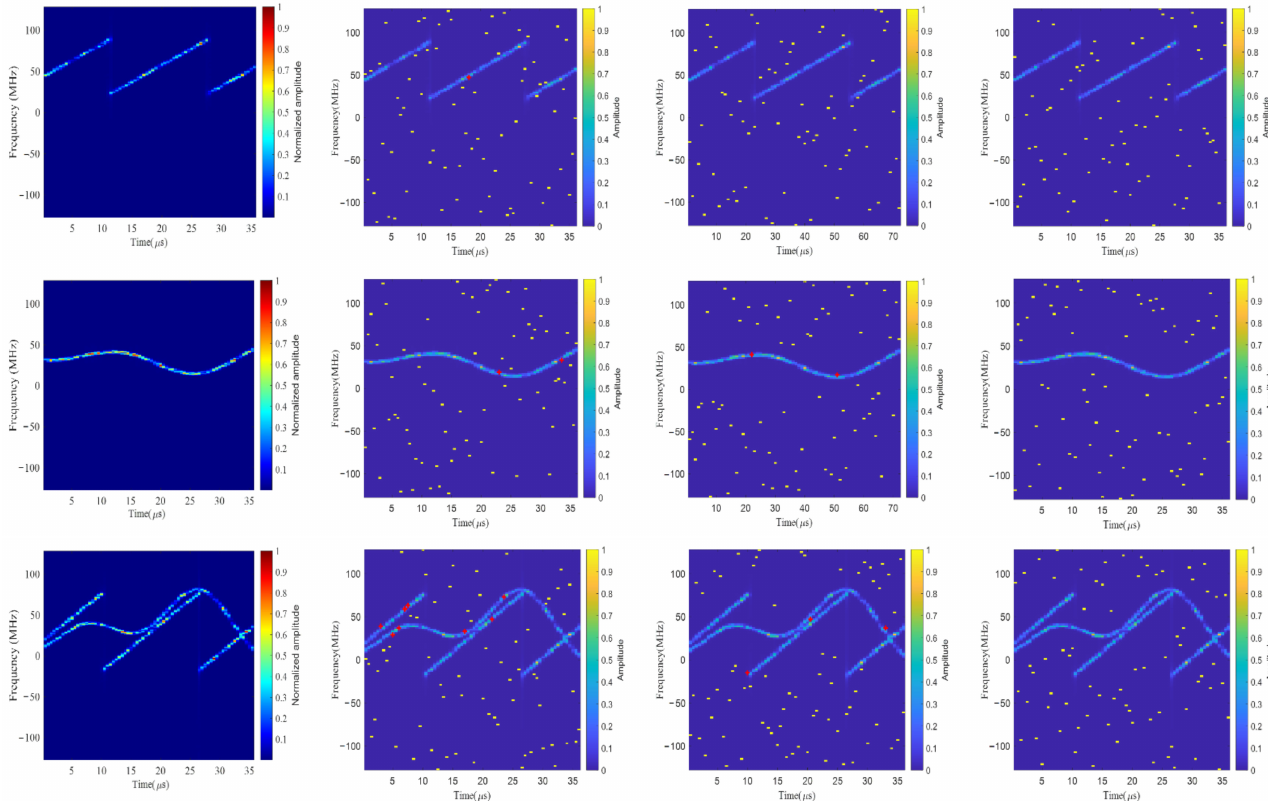
Figure 10. The TF images of different WBIs (CM-WBI only, SM-WBI only, and the mixed WBI from top to bottom) in the duration of measurement and the transmitting waveforms designed via different methods (random selection, the SWD method, and the proposed method from second to last